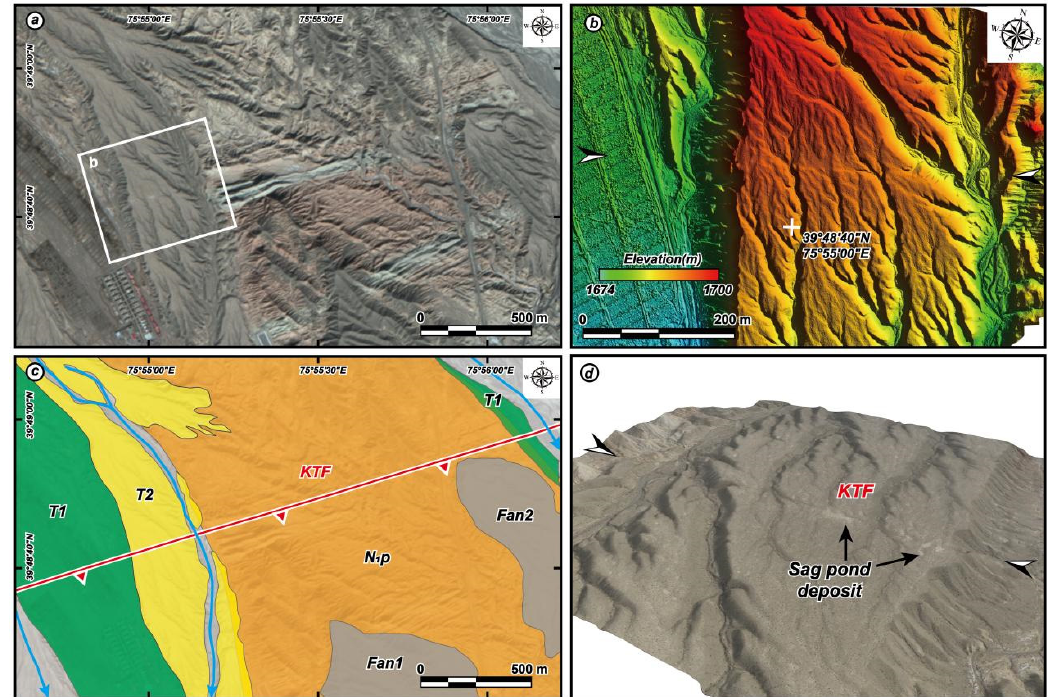
Figure 4. The tectono-geomorphic features in the Ayakeqianake (site 1 as shown in Figure 2b) ( a ) GF-2 satellite image showing the surface rupture break through the T2 surface of Ayakeqianake river and Miocene sedimentary rocks. ( b ) The Digital Surface Model (DSM) generated by the UAV-based photogrammetry showing a linear fault scarp was developed on the T2 surface, the black and white arrows present the trace of surface rupture; ( c ) interpretation of the GF-2 image; ( d ) The UAV Digital Orthophoto Map (DOM)-based 3D perspective image showing the geomorphic details of fault scarp along the KTF (black and white arrows), noting that the sag pound deposit in front of the fault scarp, which is most likely associated with the latest seismic event, and the view direction towards the fault scarp is shown in Figure 4b.